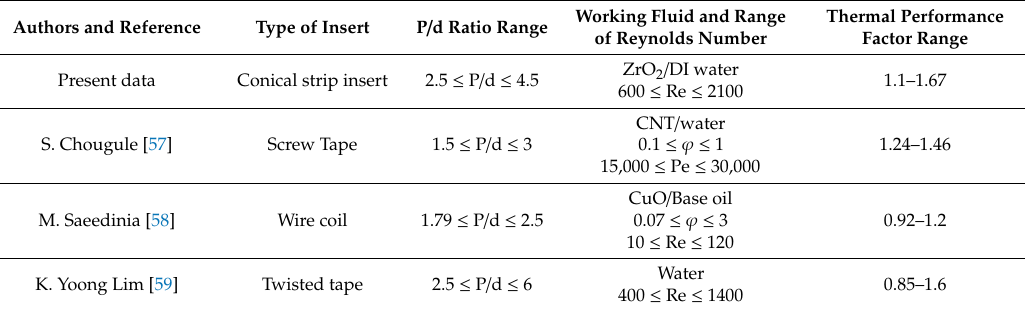
Table 5. Comparison of the thermal performance factor with previous